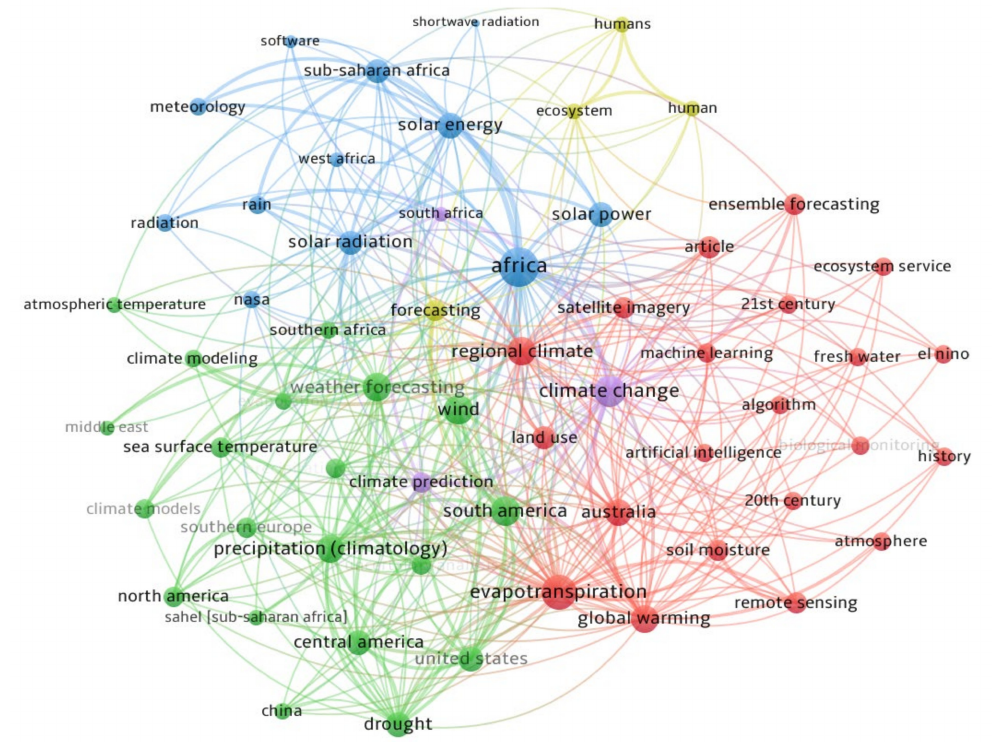
Figure 6. Keyword co-occurrences based on published documents covering the southern Africa